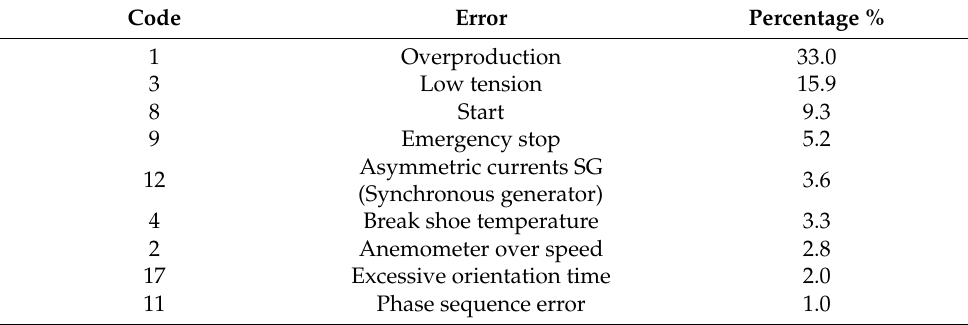
Table 1. Errors with the more important percentage of